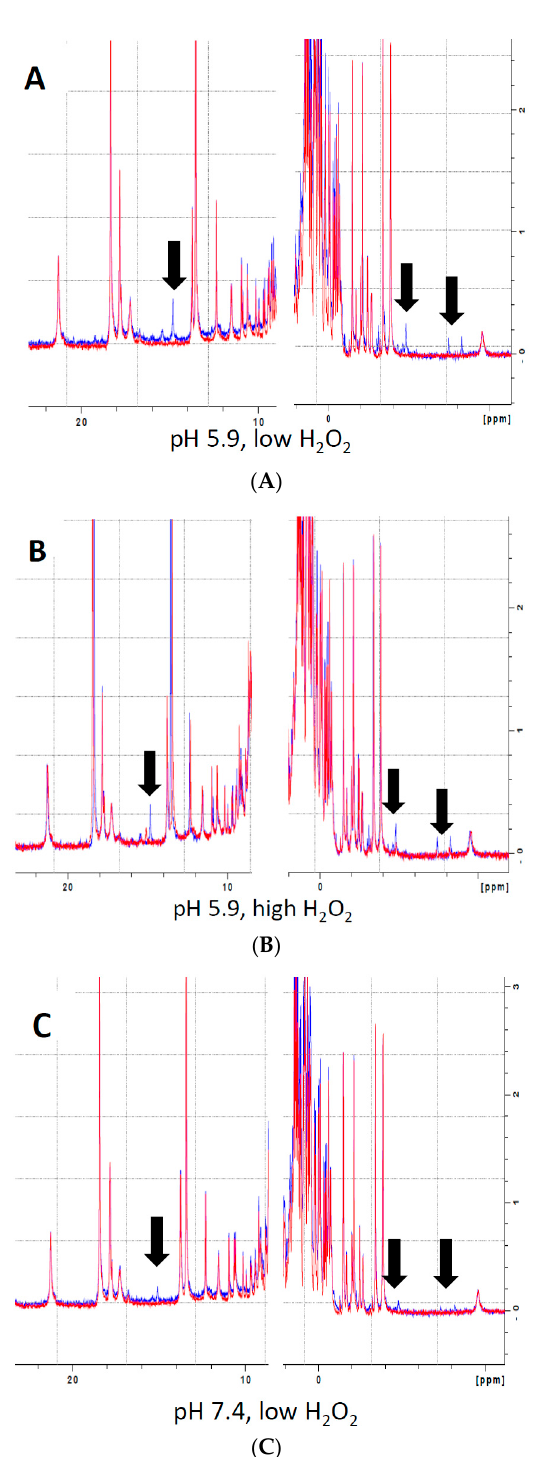
Figure 2. Analysis of heme-protein crosslinks by 700 MHz 1 H NMR spectra. ( A – B ) MetMb (555 µM, pH 5.9) was reacted with 110 µM H 2 O 2 ( A ) or 1.1 mM H 2 O 2 ( B ) for 10 min before adding 3 mM NaCN to generate low-spin Mb. Sample preparation and 1 H NMR procedures are described in the methods section. ( C ) Same as ( A ) and ( B) , only metMb was reacted with 110 µM H 2 O 2 at pH 7.4. Data for untreated metMb are in red, and data for metMb pretreated with H 2 O 2 are in blue. Arrows indicate novel peaks in the heme region for H 2 O 2 -treated